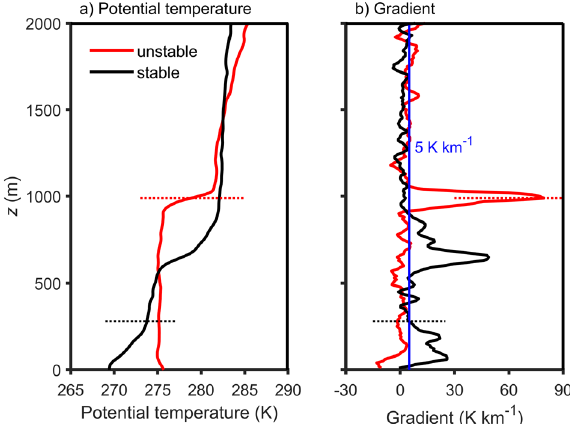
Fig. 10 Schematic diagram of ABLH determination under different strati fi cation conditions. a Typical thermal structure of the ABL under unstable and stable conditions; b The potential temperature gradient corresponding to the pro fi les in a